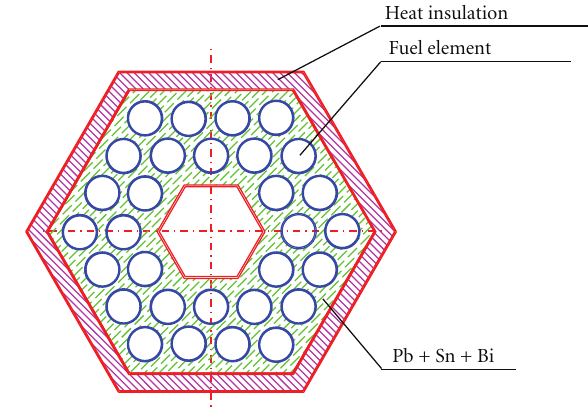
Figure 2: Design variant of fuel rod assembly for liquid metal thermal